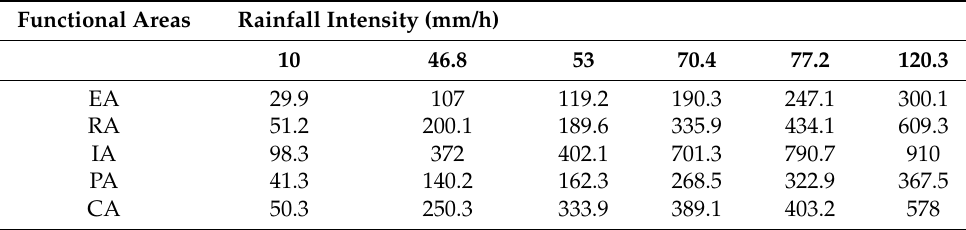
Table 5. Combined load (RDS index,load ) in (kg) of heavy metals in all functional areas. Functional